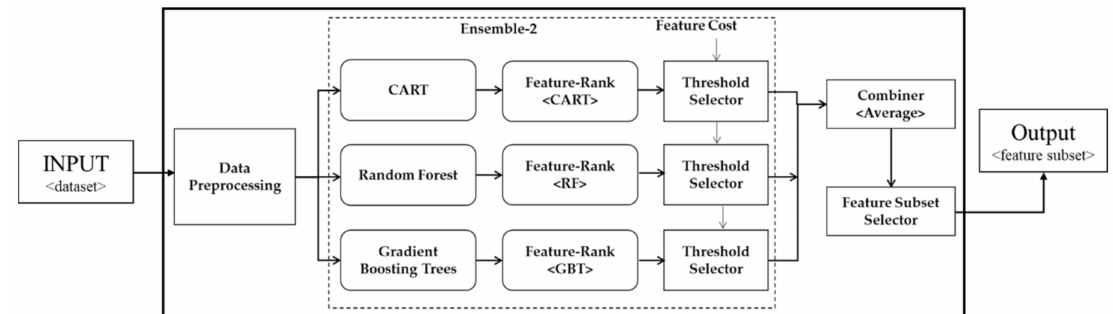
Figure 3. The architecture of the proposed ensemble-1.